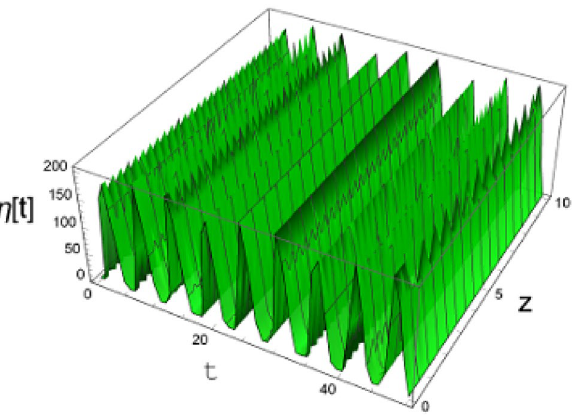
Figure 13. The estimate uniform solution of the surface deflection as given in Eq. (84).